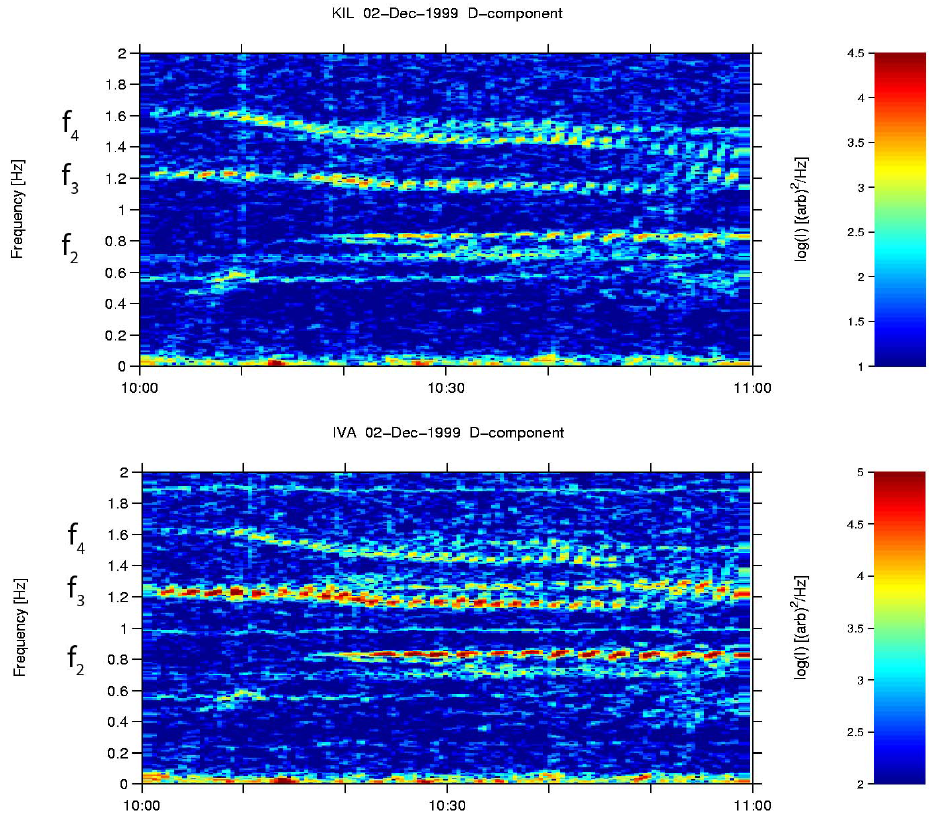
Fig. 1. The dynamic spectra (D-components) of a multiband Pc1 event registered at the Kilpisj¨arvi (KIL) and Ivalo (IVA) stations on 2 December 1999 between 10:00–11:00 UT. (IVA, geographic coordinates 68.7 ◦ latitude, 27.3 ◦ longitude, 65.0 ◦ CGM latitude, 109.8 ◦ CGM longitude, L = 5.6)